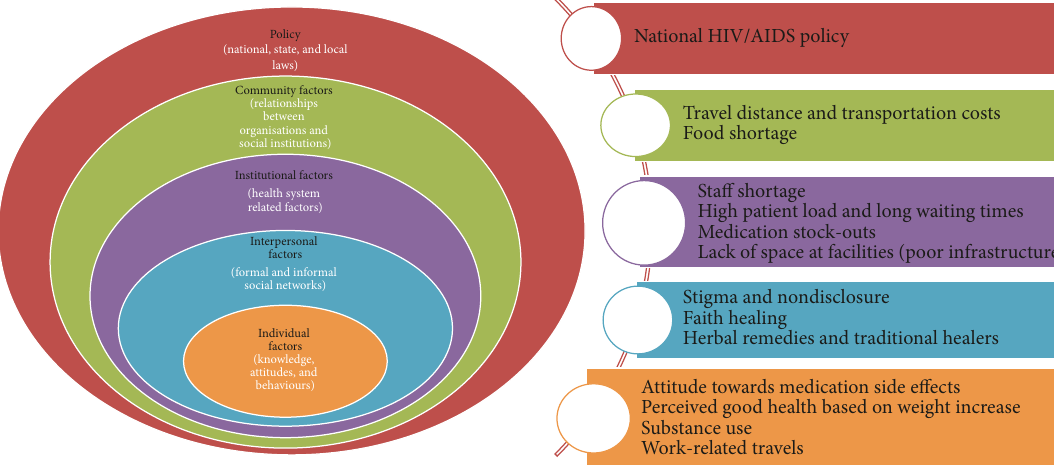
Figure 2: Summary of themes identified based on the components of the ecological